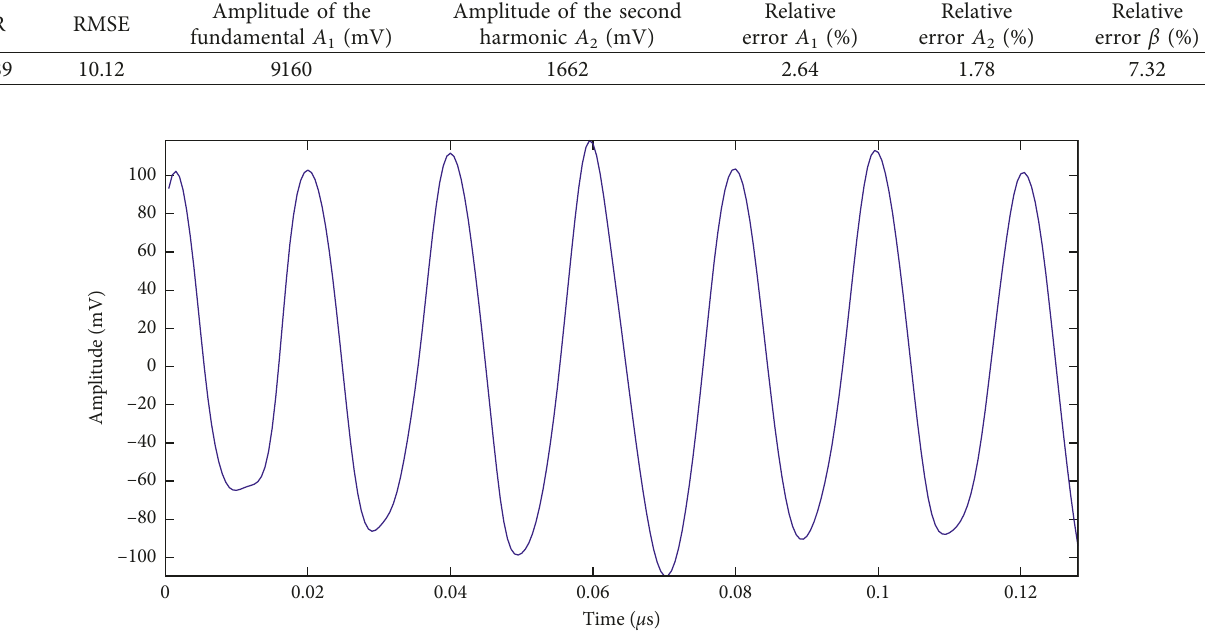
Figure 7: Time-domain curve after wavelet and EEMD joint denoising.